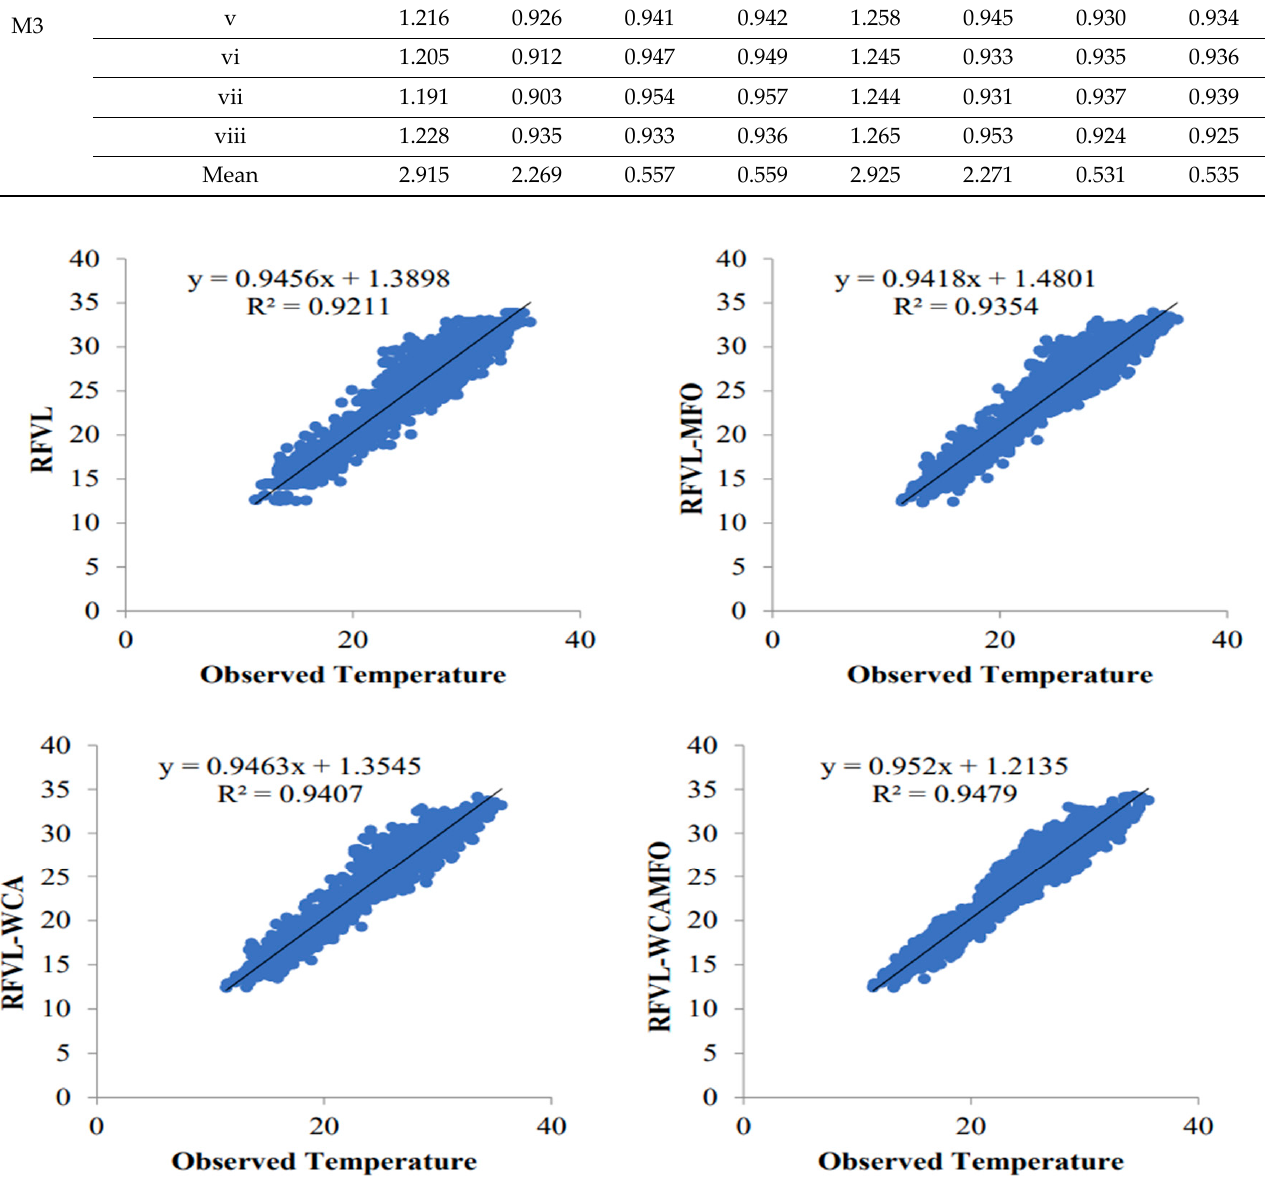
Figure 7. Scatterplots of the observed and predicted temperature by different RVFL-based models in the test period using best input combination for daily time scale. Table 9. The results of the model RVFL-MFO for daily time scale.